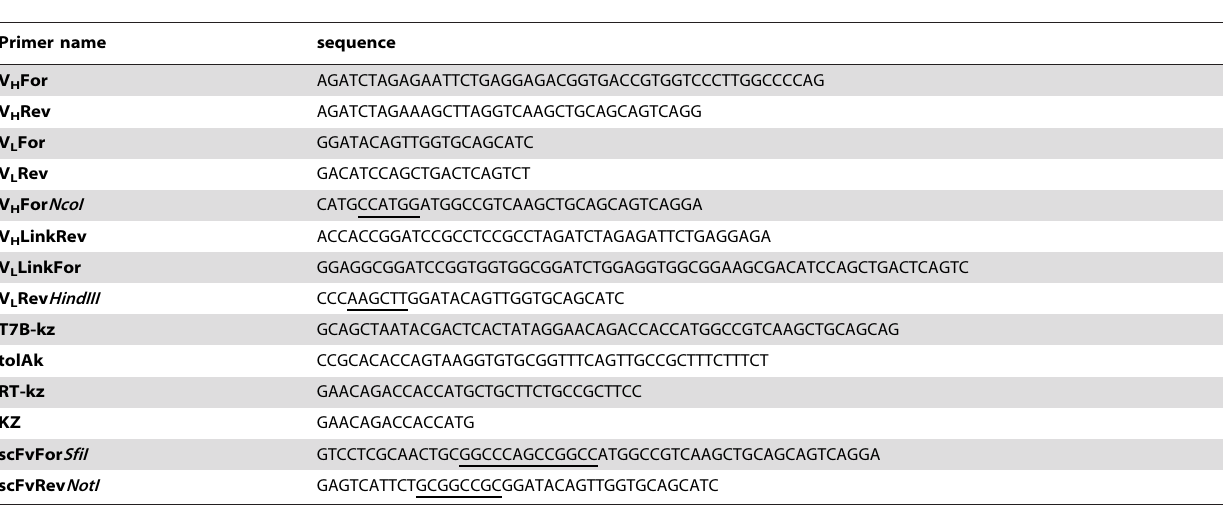
Table 1. Synthesized oligonucleotides for the construction of scFv and ribosome display